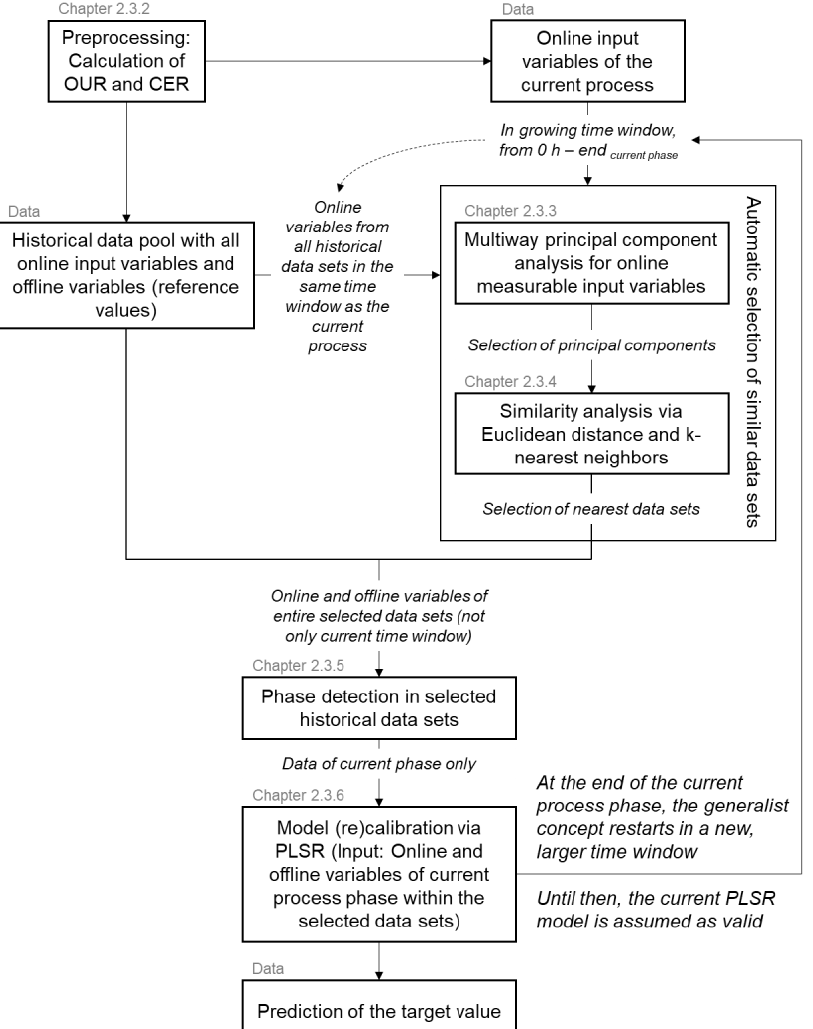
Figure 1. Structure of the generalist soft sensor concept. OUR = oxygen uptake rate; CER = carbon dioxide evolution rate; PLSR = partial least squares regression.